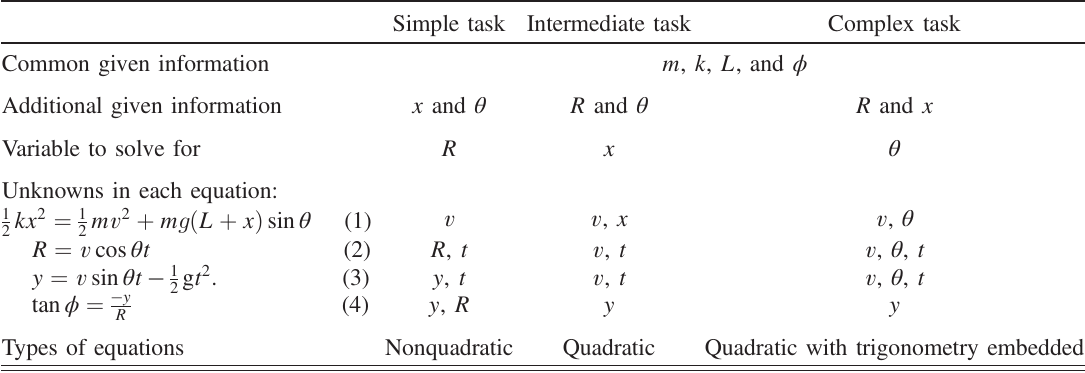
TABLE I. Known and unknown variables, and types of equations across sequential synthesis tasks with increasing mathematical complexity ( m , mass of block; k , spring constant; L , equilibrium position; ϕ , angle of final slope; x , initial compression of spring; θ , angle of initial slope; R , horizontal distance; v , block ’ s velocity at crest of the ramp; y , block ’ s final vertical position; t , time taken by block to hit the landing spot). Types of equations refer to the final equation obtained after manipulation, from which a value for the unknown variable of interest ( R , x , and θ ) can be found. See Appendix A for the